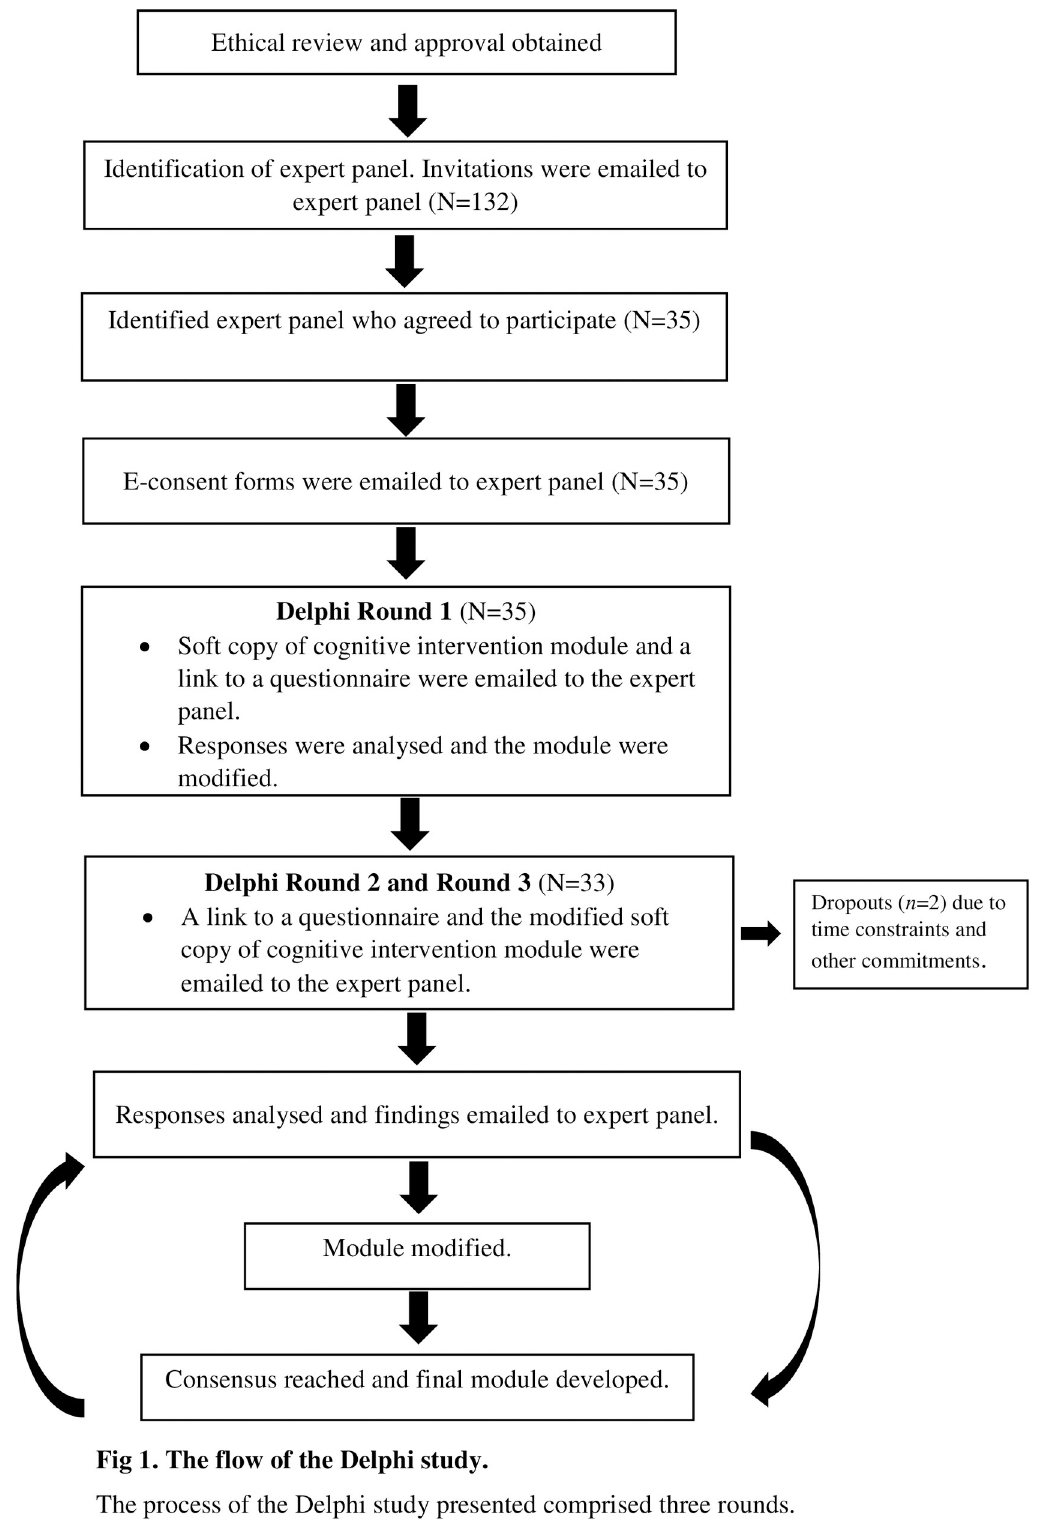
Fig 1. The flow of the Delphi study. The process of the Delphi study presented comprised three rounds.